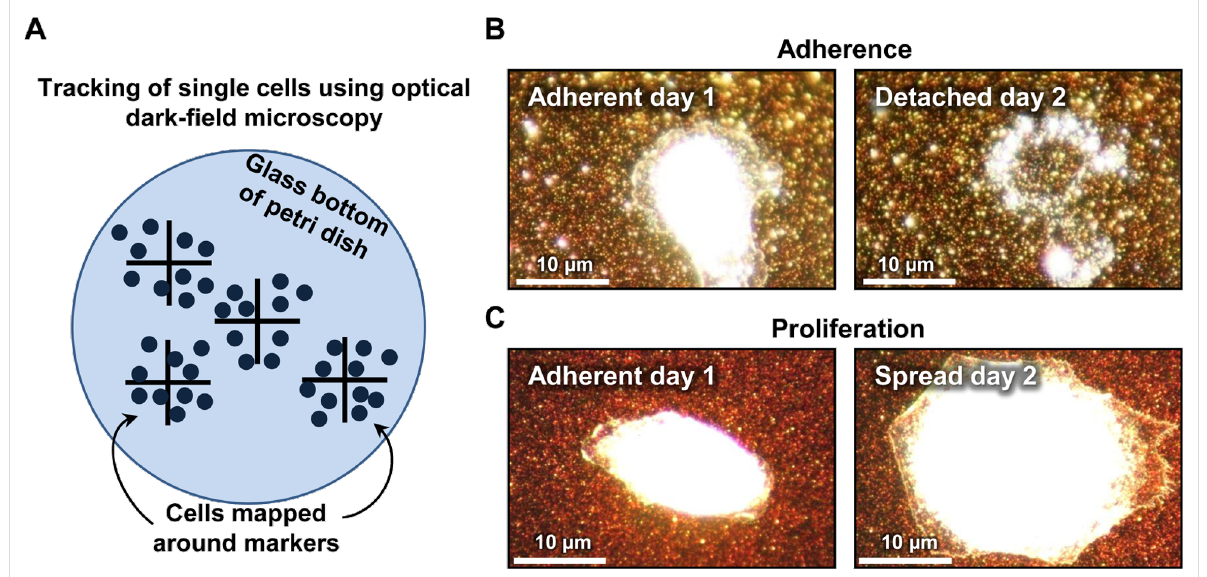
Figure 2: Live cell imaging. (A) Scratches into the glass were used as position markers in the glass bottom of a petri dish. After seeding, the cells were mapped around the markers and imaged daily over a period of three days. (B) Representative example for an adherent cell at day 1 shown on the left side, which disappeared at day 2, leaving behind the cell debris shown on the right side. (C) Representative example for an adherent cell at day 1 shown on the left side, which has considerably expanded its spreading area at day 2, indicating an active proliferation shown on the right side.